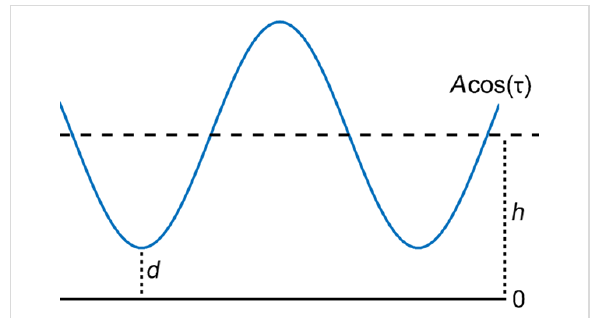
Figure 1: Illustration of a tip trajectory with a perfect sinusoidal shape in the noncontact dynamic AFM mode. The blue line represents the tip motion about the equilibrium position of the cantilever, while the solid black line represents the surface position, fixed at reference point zero. h is the cantilever rest position and d is the instantaneous tip–sample